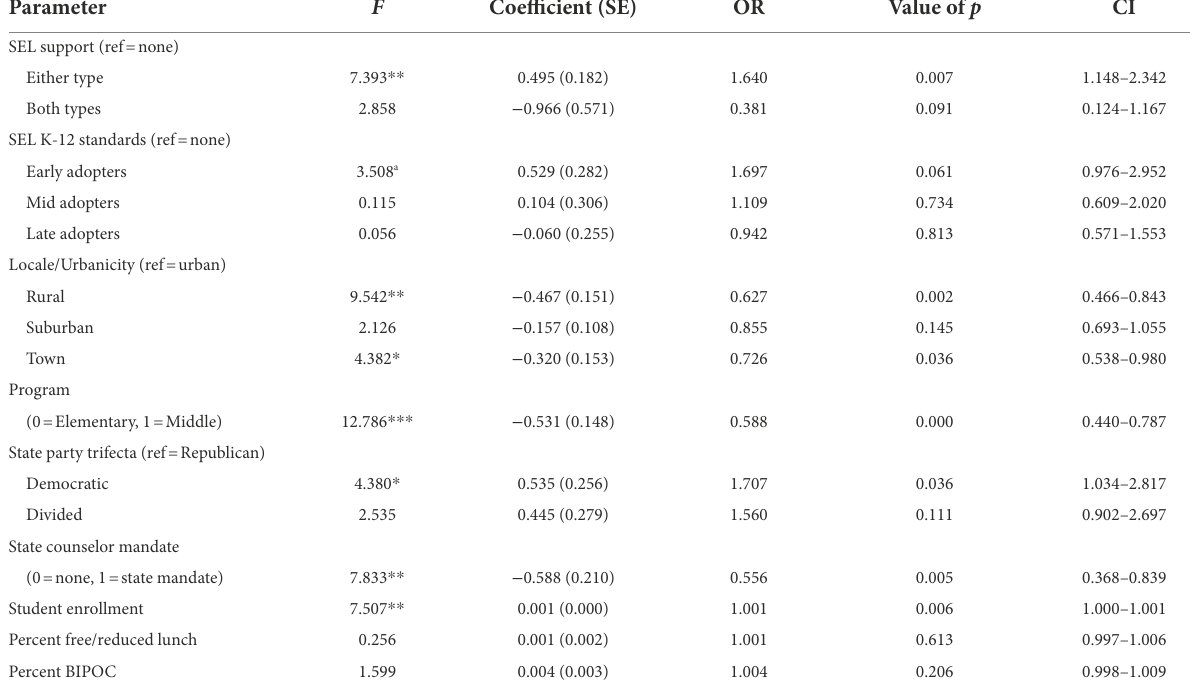
TABLE 3 Results of generalized linear mixed model analysis: fixed effects.